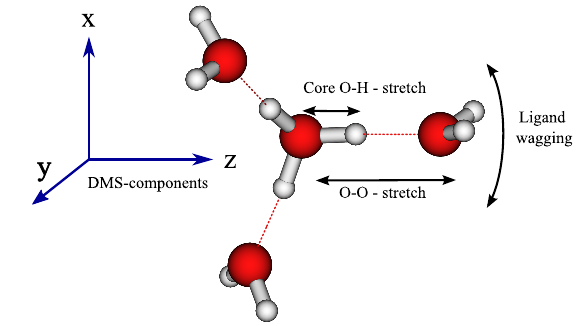
Fig. 3 | Illustration of ligand wagging, core O – H stretch and O – O stretching motion of H 9 O + 4 exemplary in one of the three arms of the cation. Note that in the ligand-wagging motion only the two hydrogen of the outer water molecules move as indicated by the arrow. The coordinate system on the left indicates the directions of components of the dipole moment surfaces (DMS).